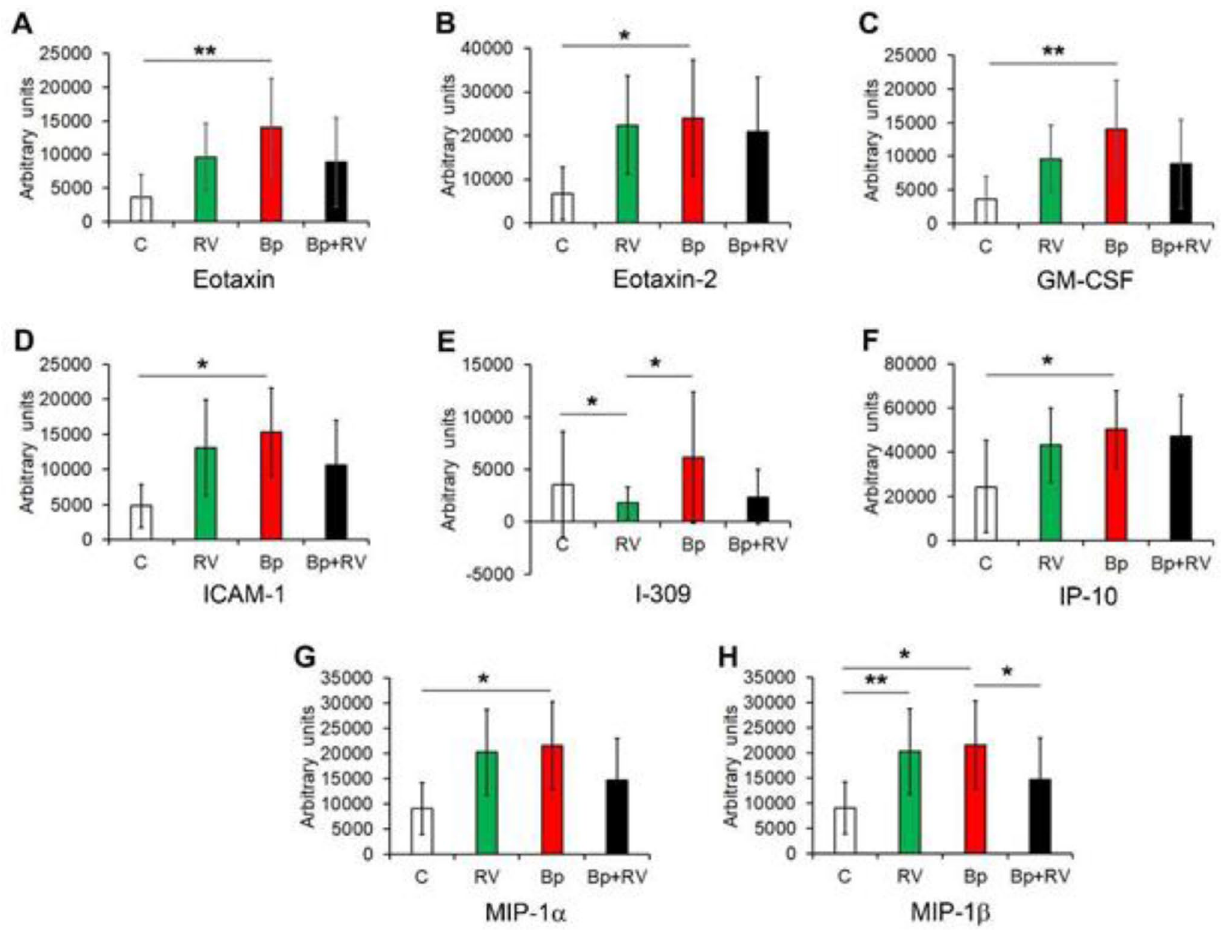
Figure 4. Differentially expressed inflammatory proteins in the screening cohort analysed by antibody array. The histograms reported the mean ± SD of semi-quantitative expression in controls (C), RV patients, Bp patients, and Bp + RV patients of Eotaxin ( A ), Eotaxin-2 ( B ), GM-CSF ( C ), ICAM-1 ( D ), I-309 ( E ), IP-10 ( F ), MIP-1α ( G ), and MIP-1β ( H ). * P < 0.05; ** P < 0.01, by